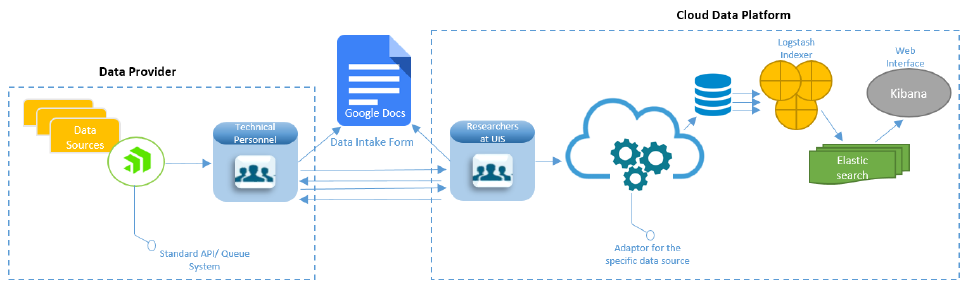
Figure 4. Data acquisition pipeline.